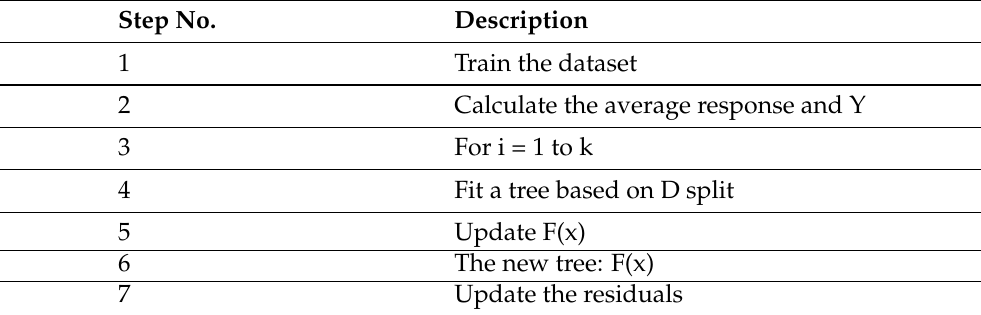
Table 3. The steps in the ensemble of trees